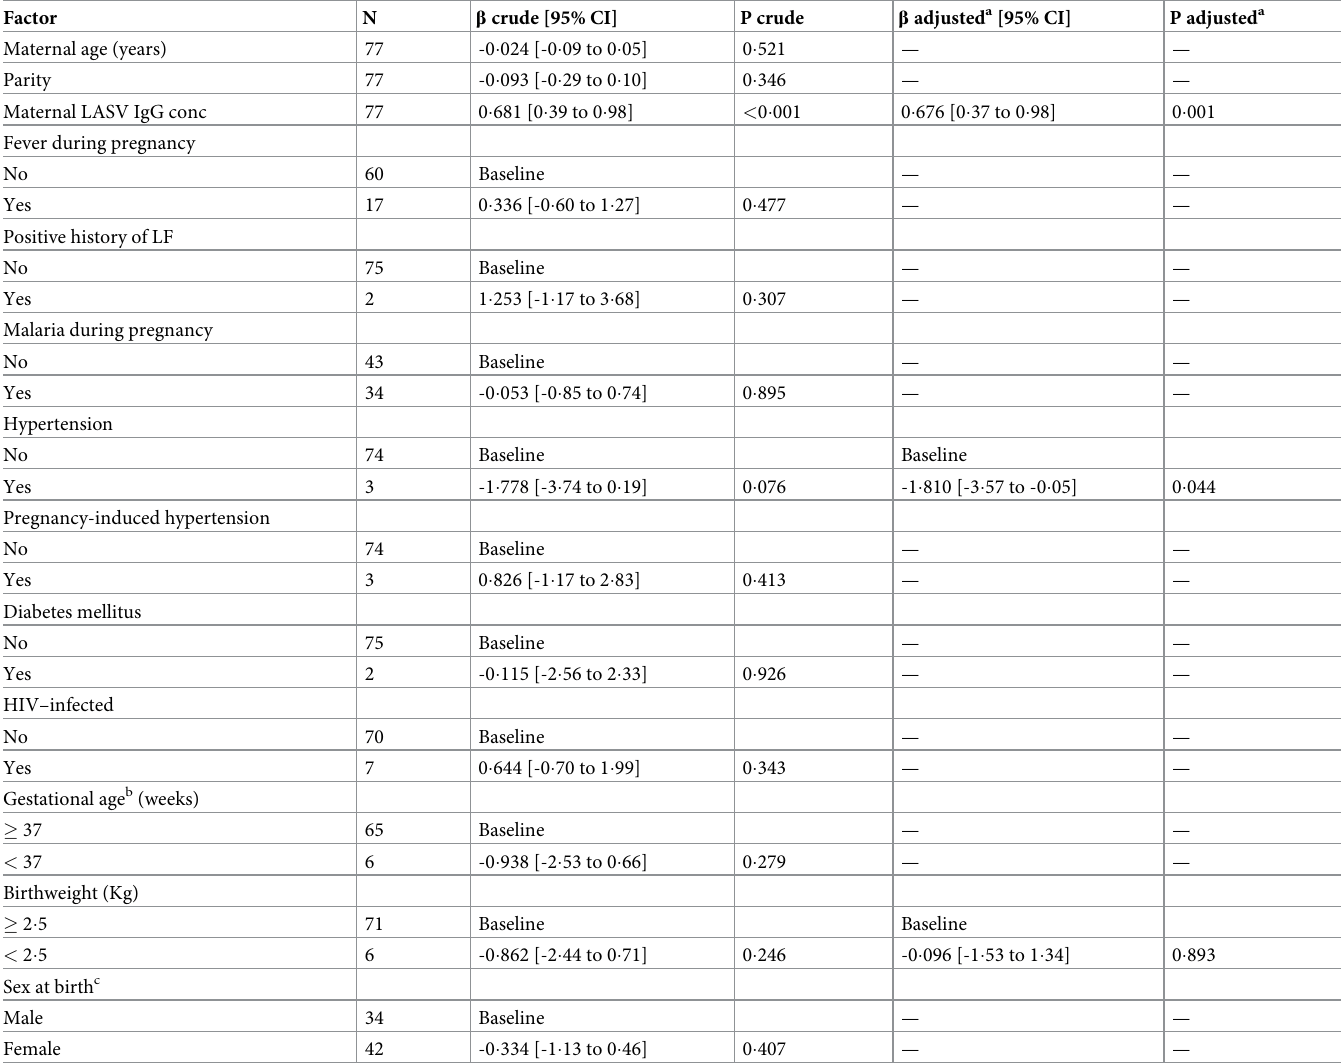
Note: β - regression coefficient showing change in cord LASV IgG concentration; CI- confidence interval; conc- concentration; IgG- immunoglobulin G; LASV- Lassa virus; LF- Lassa fever; N- total number of pregnant women included in analysis. a Adjusted for factors marginally significant in the univariate regression (crude p < 0 � 25), except collinear terms. b Based on Ballard’s’ score, data missing for 6 women. c Data missing for 1